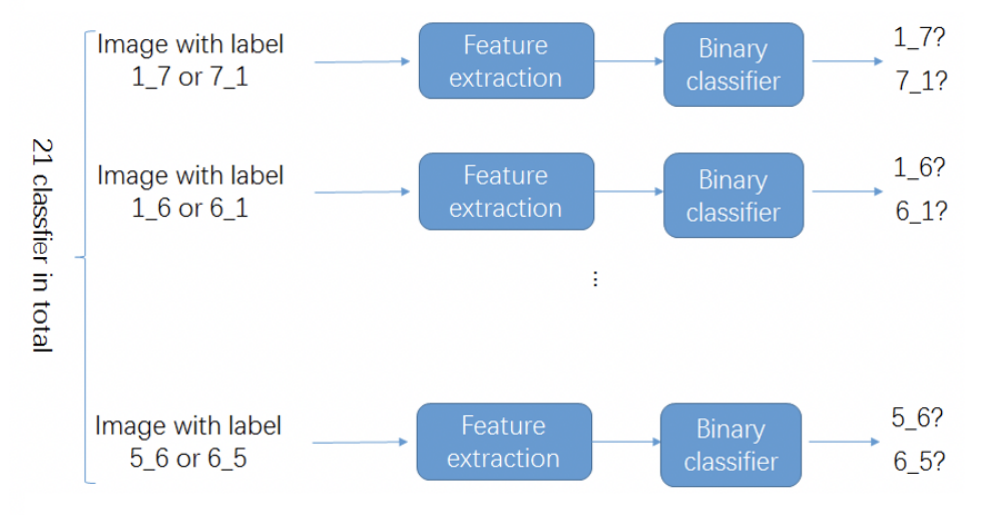
Figure 6. Binary classifications for classifying the symmetrical labels.